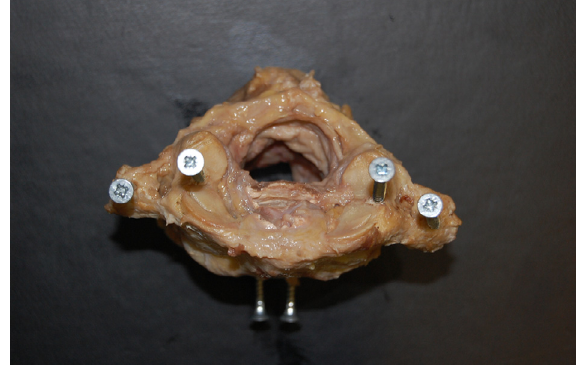
Figure 2. C1-C2 fresh-frozen cadaveric spine C1-C2 complex viewed from superior aspect. Two screws were inserted into the lateral masses, two screws were inserted into the transverse processes and two screws were inserted from anterior to posterior direction into the C2 vertebral